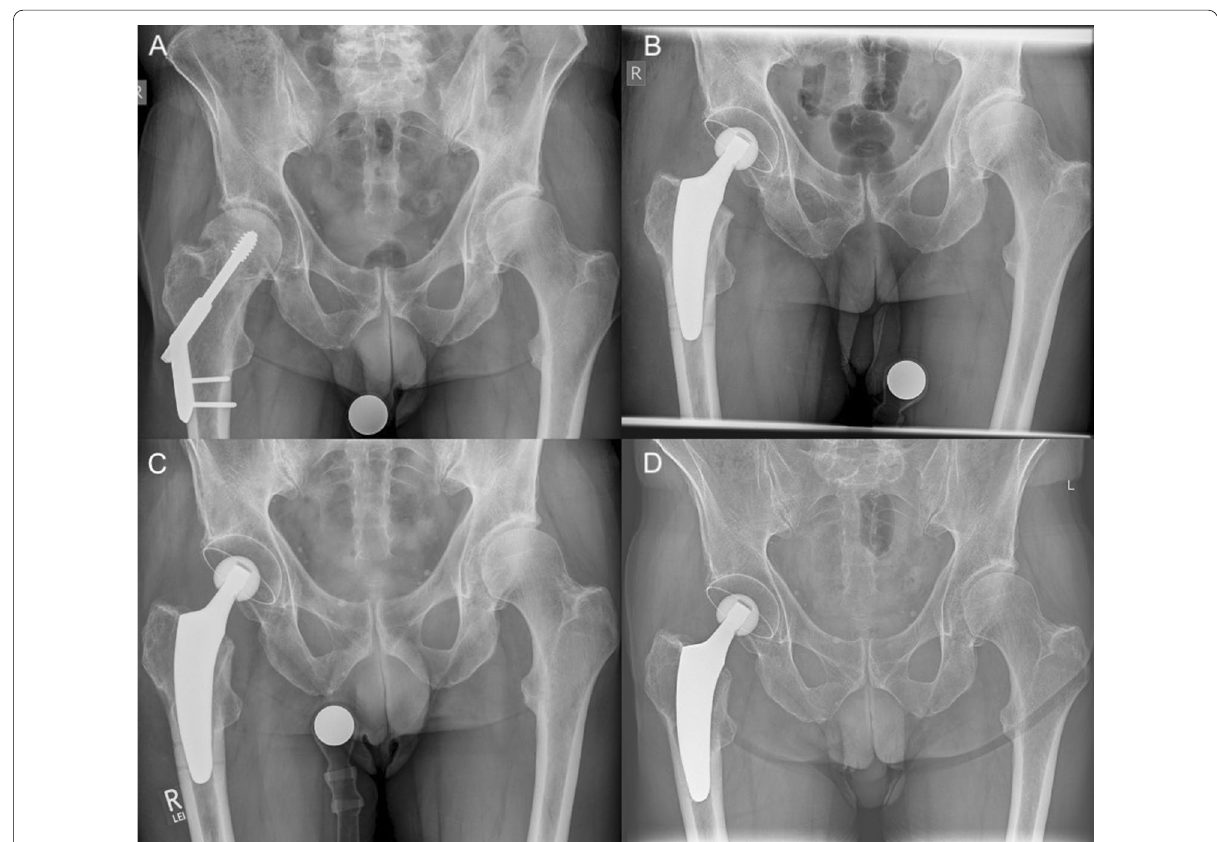
Fig. 4 Radiographs of a 73-year-old male patient with hardware failure: A preoperative; B postoperative with fit-and-fill fixation; C 6-week follow-up; D 49-month follow-up (no signs of loosening or